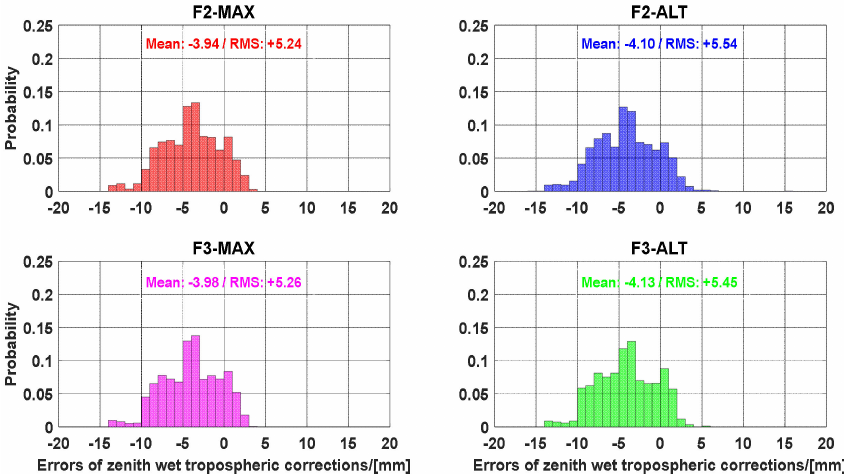
Figure 9. Error distribution of the zenith wet tropospheric corrections from BRUX station.